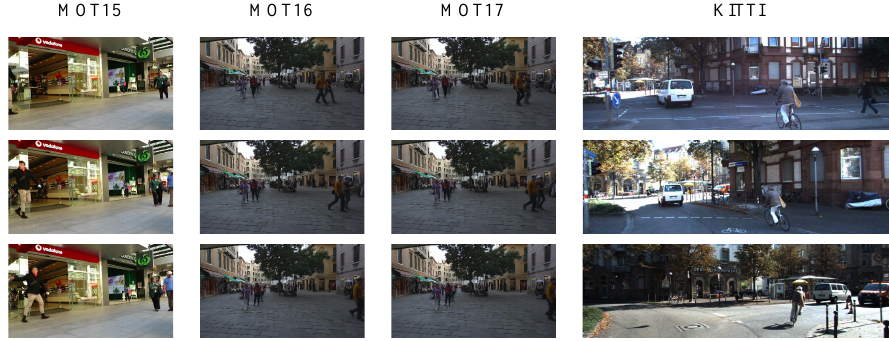
Figure 18. MOT15 [8], MOT16 [141], MOT17, and KITTI [142] benchmark